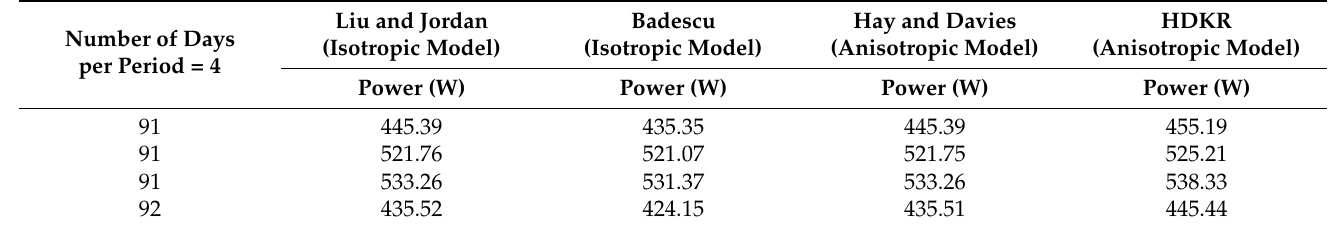
Table 4. Power output results for Dhahran city for NP = 4.